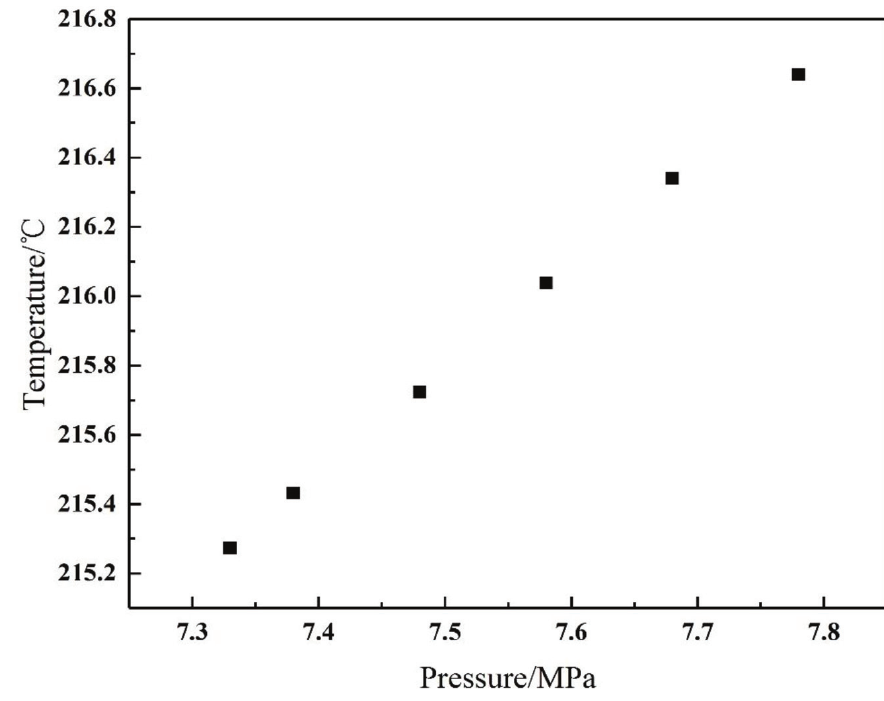
Figure 5. Effect of pressure on crystallization temperature.